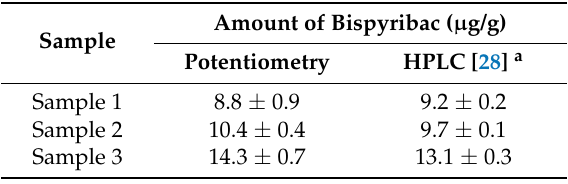
Table 3. Determination of bispyribac in some soil samples were collected after one day of spraying bispyribac herbicide to the